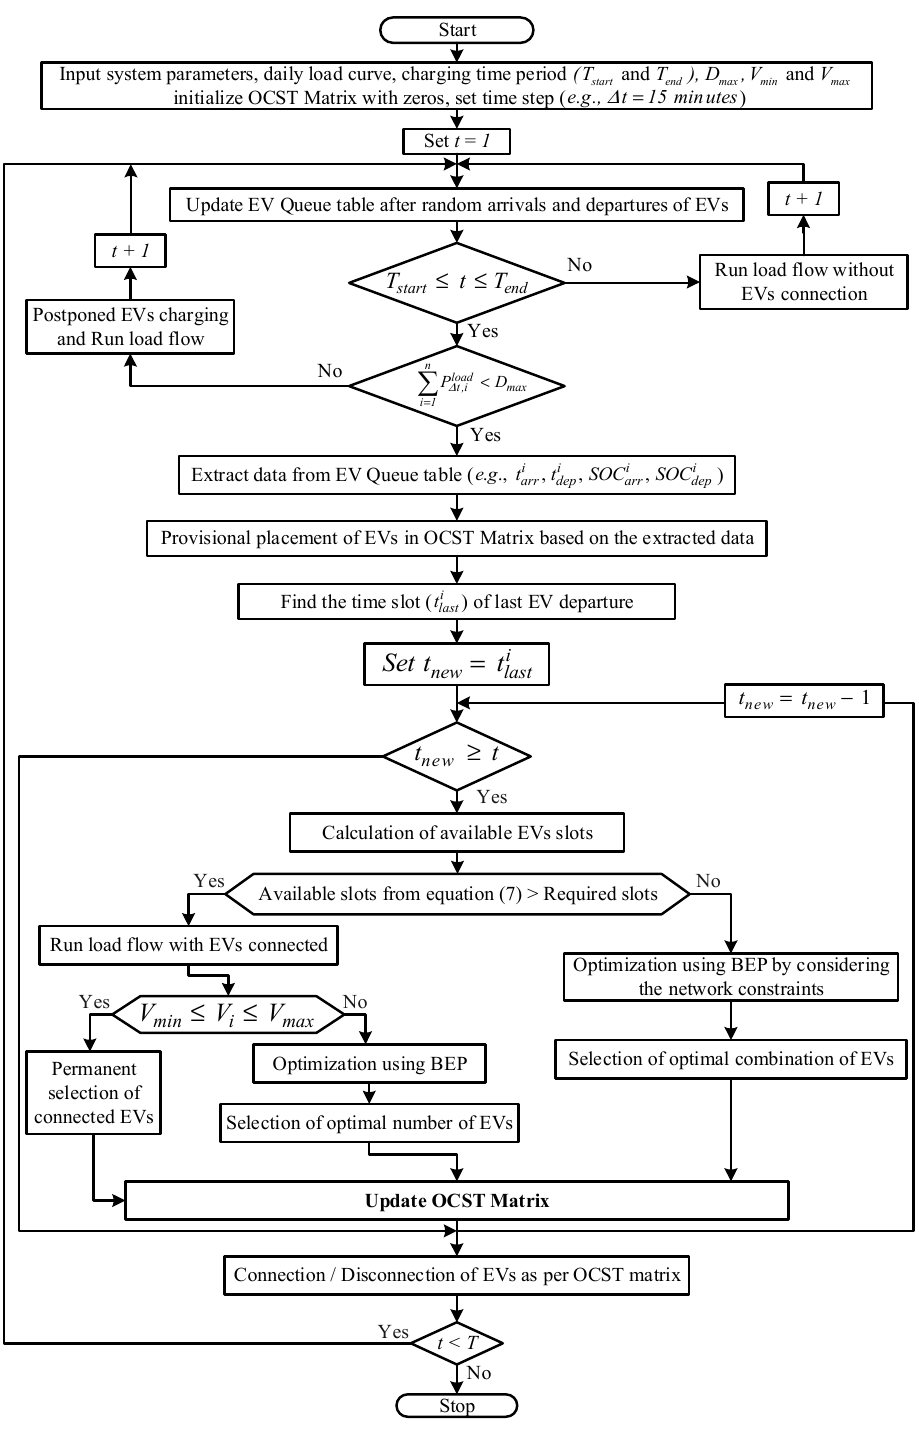
Figure 1. Flowchart of proposed coordinated EVs’ charging technique.